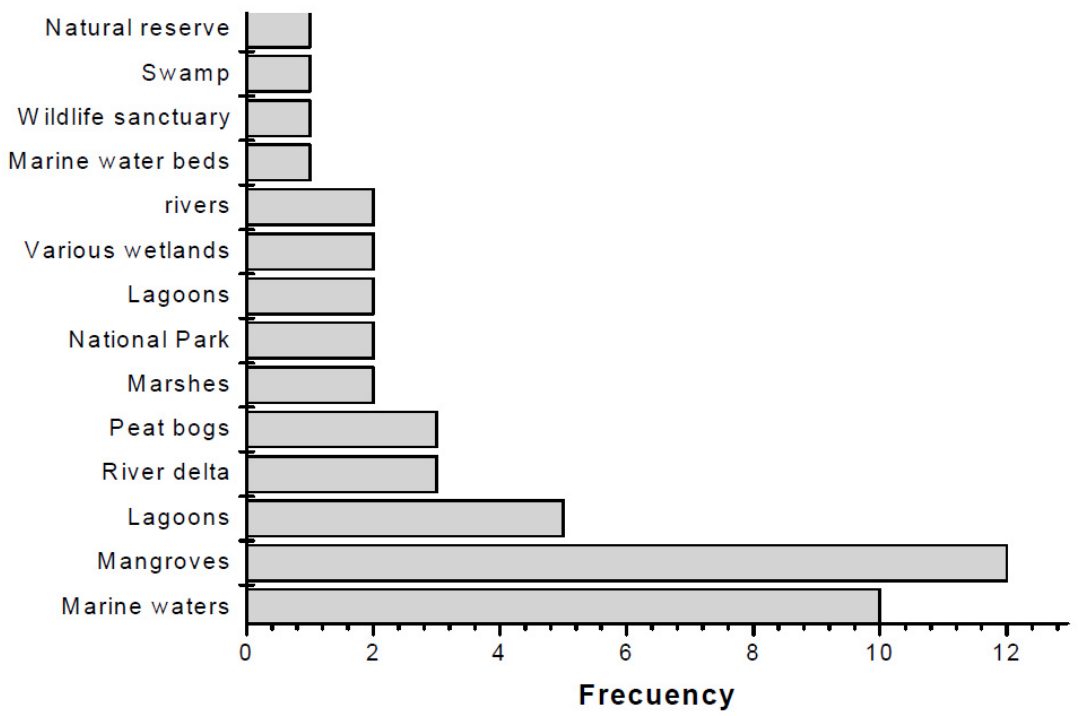
Figure 8. Frequency distribution of the types of wetlands affected in Asia.